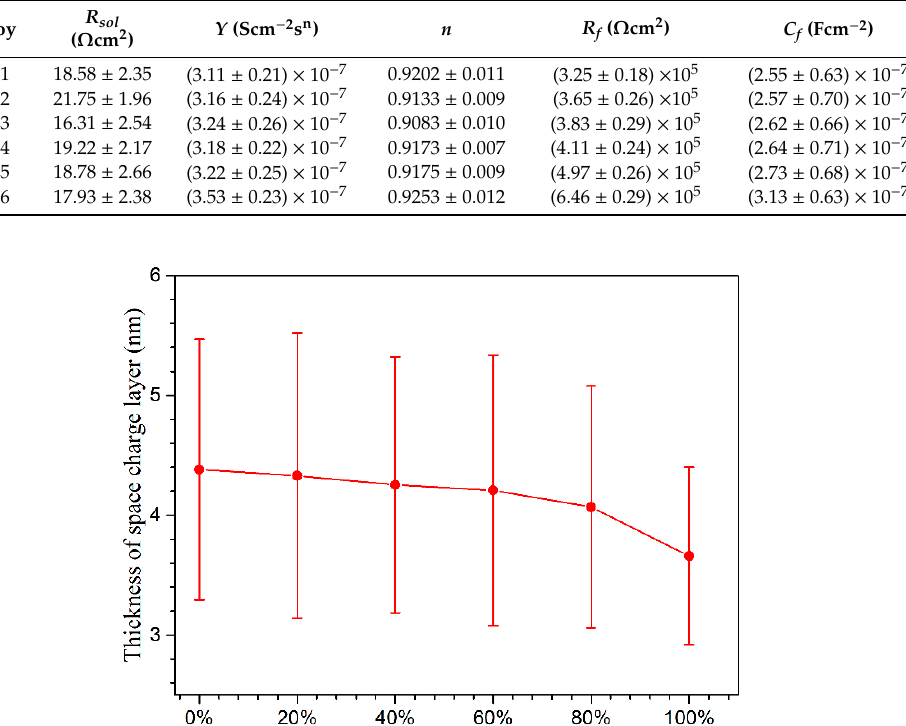
Table 3. The fitted results of EIS plots about the passive film formed on sintered alloys in 0.2 M Na 2 SO 4 + 0.01 M NaCl solution, the standard deviation coms from five valid parallel results.